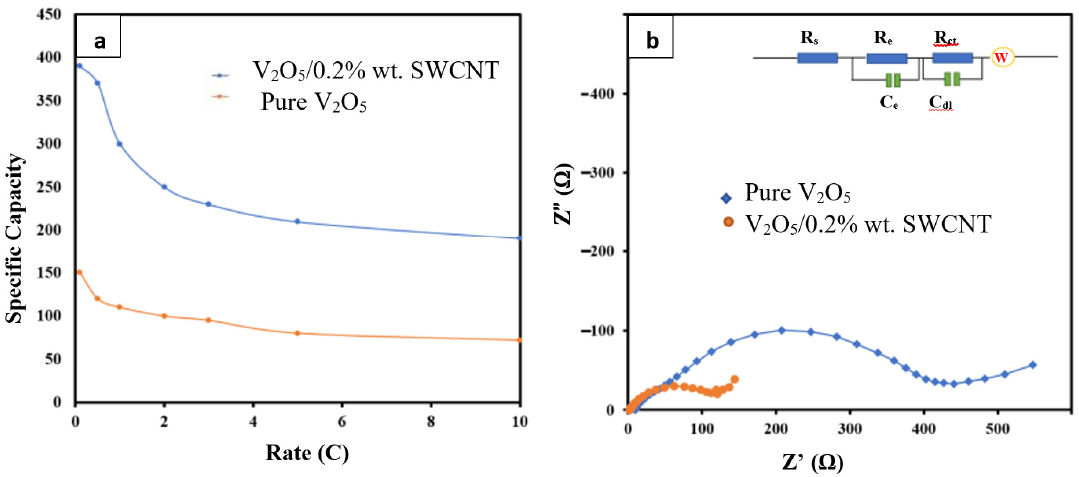
Figure 8. Rate performance comparison and Nyquist plot. ( a ) Rate performance of cells at different C-rate. ( b ) Nyquist plot of pristine V 2 O 5 and V 2 O 5 /0.2% wt. SWCNT cells; amplitude: 5 mV; frequency:0.01 Hz ‐ 1 MHz.